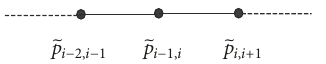
Figure 6: When 𝑛 0,𝑑 < 0 .